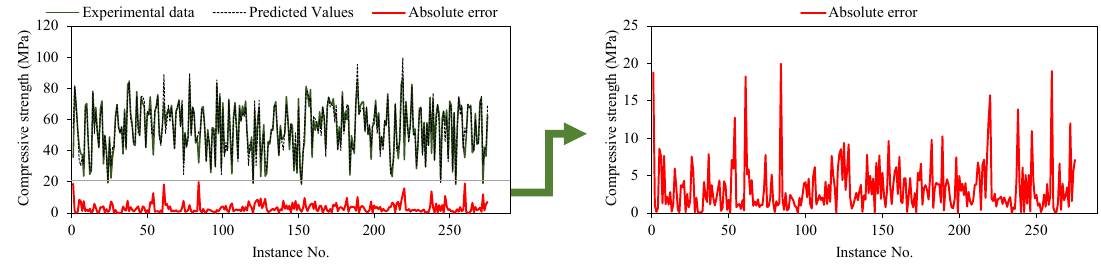
Figure 7. Error Analysis for the optimized trial.